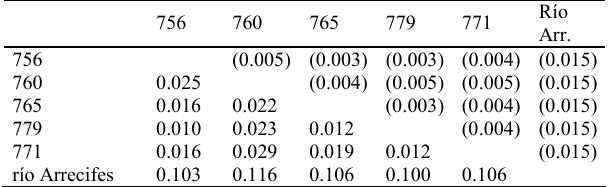
Table 3. Nucleotide diversity ( (cid:83) ) for Pimelodus albicans for each locality from the río de la Plata and río Arrecifes. D = Neutrality test (Tajima, 1989). Fs = Neutrality test (Fu, 1997) corresponding to río de la Plata and río Arrecifes sites.